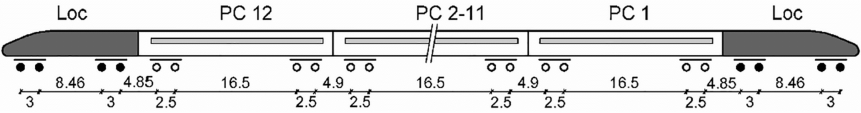
Figure 5. Axle distance and configuration for a typical ICE-2 X [40].